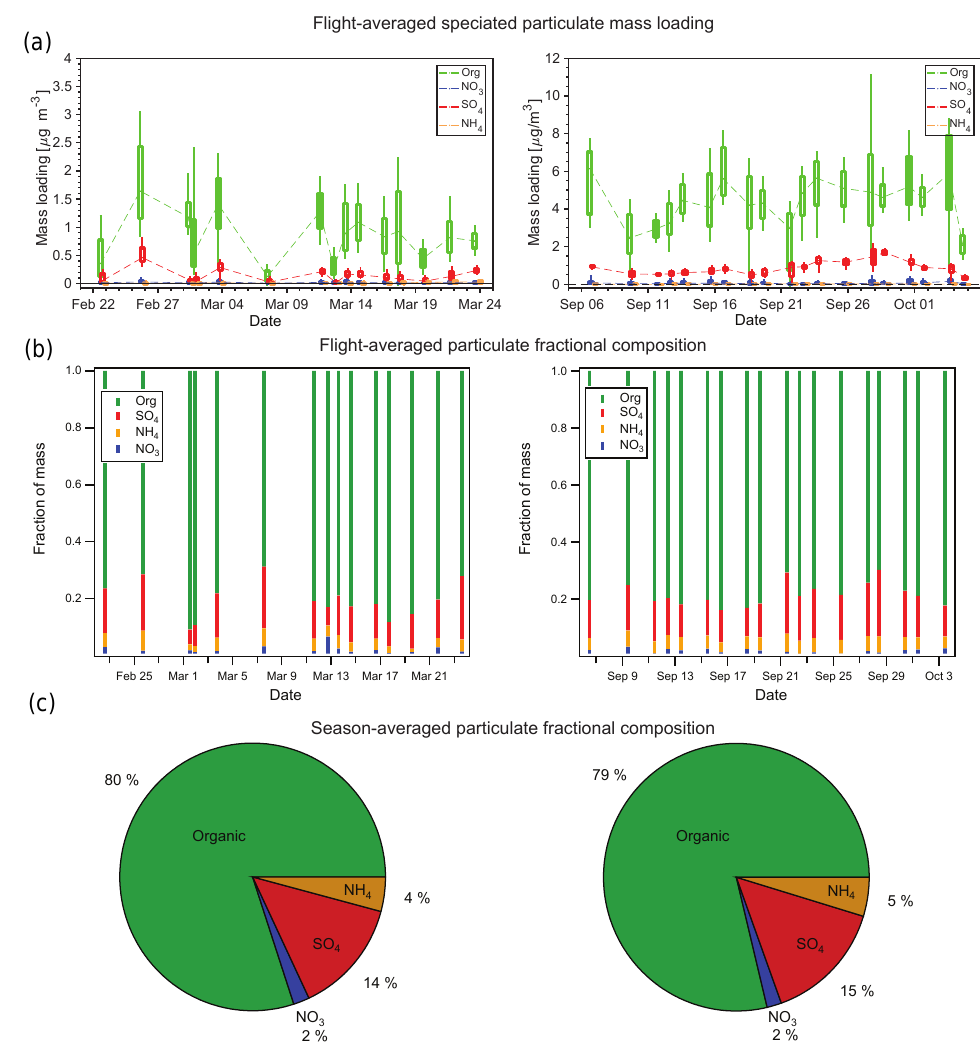
Figure 2. Box-and-whisker representations of the G-1 AMS data for both the wet and dry seasons (a) , average particle chemical composition for each flight (b) , and average aerosol chemical composition for all flights (c) . Boxes represent the quartiles, with whiskers extending to 10% and 90% and the median values shown as dots. Lines between the boxes connect the median and are drawn to guide the eye. Note the scale change between the wet- and dry-season box-and-whisker plots. AMS data are normalized to 23 ◦ C and